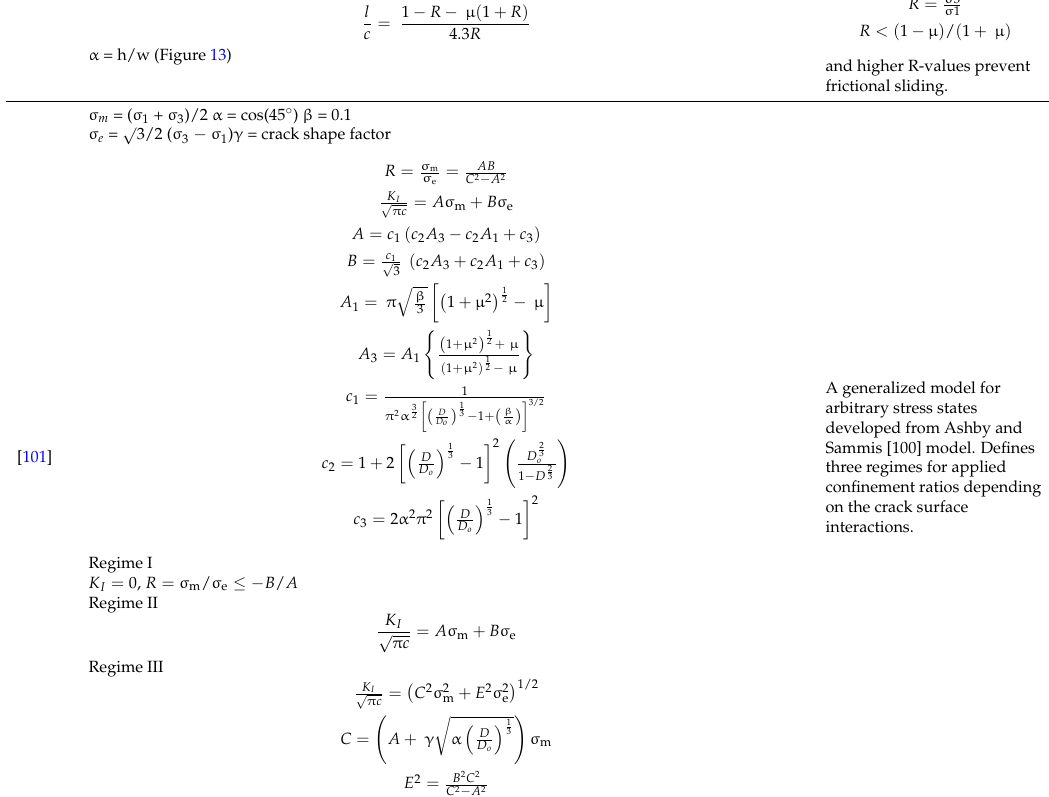
Applicable when only under uniaxial compression. Failure initiated from bending of microcolumns generated by splay cracking.